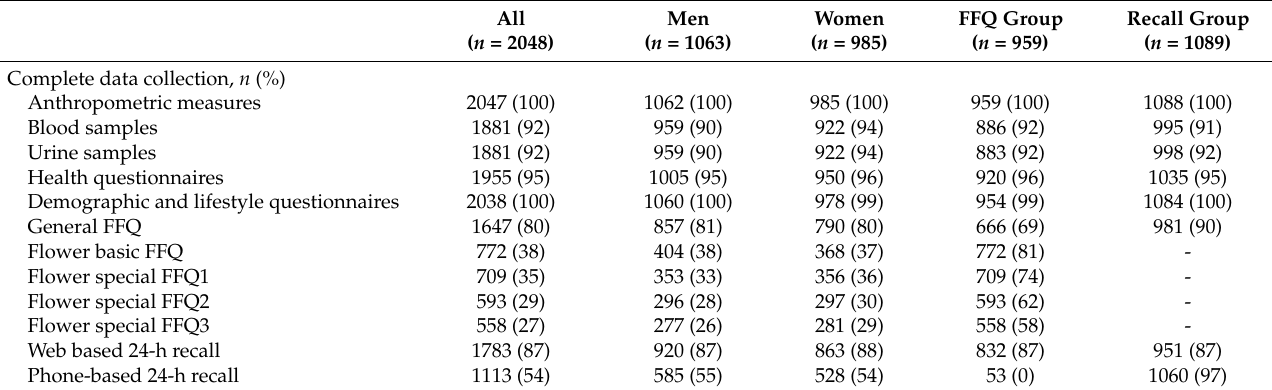
Table 2. Sample sizes ( n ) of the data collected in view of the NDARD project.